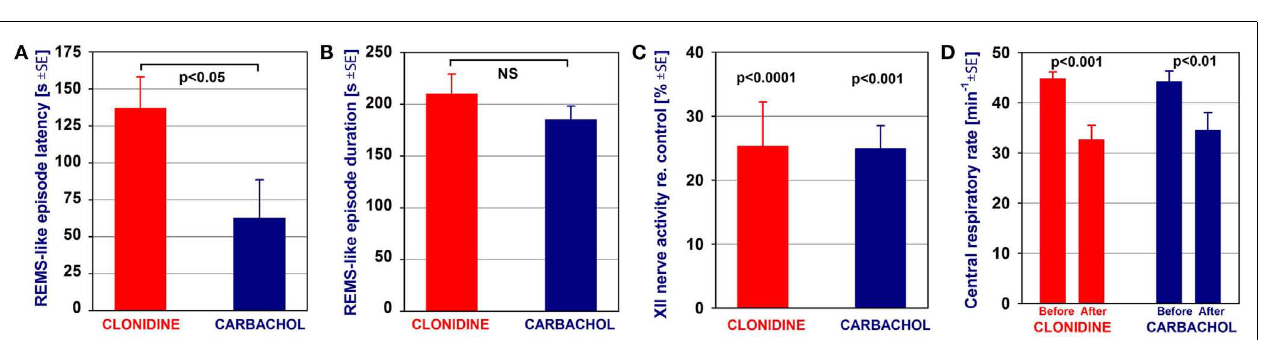
different between the episodes elicited by clonidine and carbachol.The bars show a comparison of the average data from nine REM sleep (REMS)-like episodes elicited by clonidine in nine rats in this study and average data from six REMS-like episodes elicited by pontine carbachol (10nl, 10mM) in six rats of one of our previous studies (Fenik et al., 2005). The significance levels shown in (C,D) refer to the differences between the measurements taken prior to and during the REMS-like episode. NS, not statistically significant.